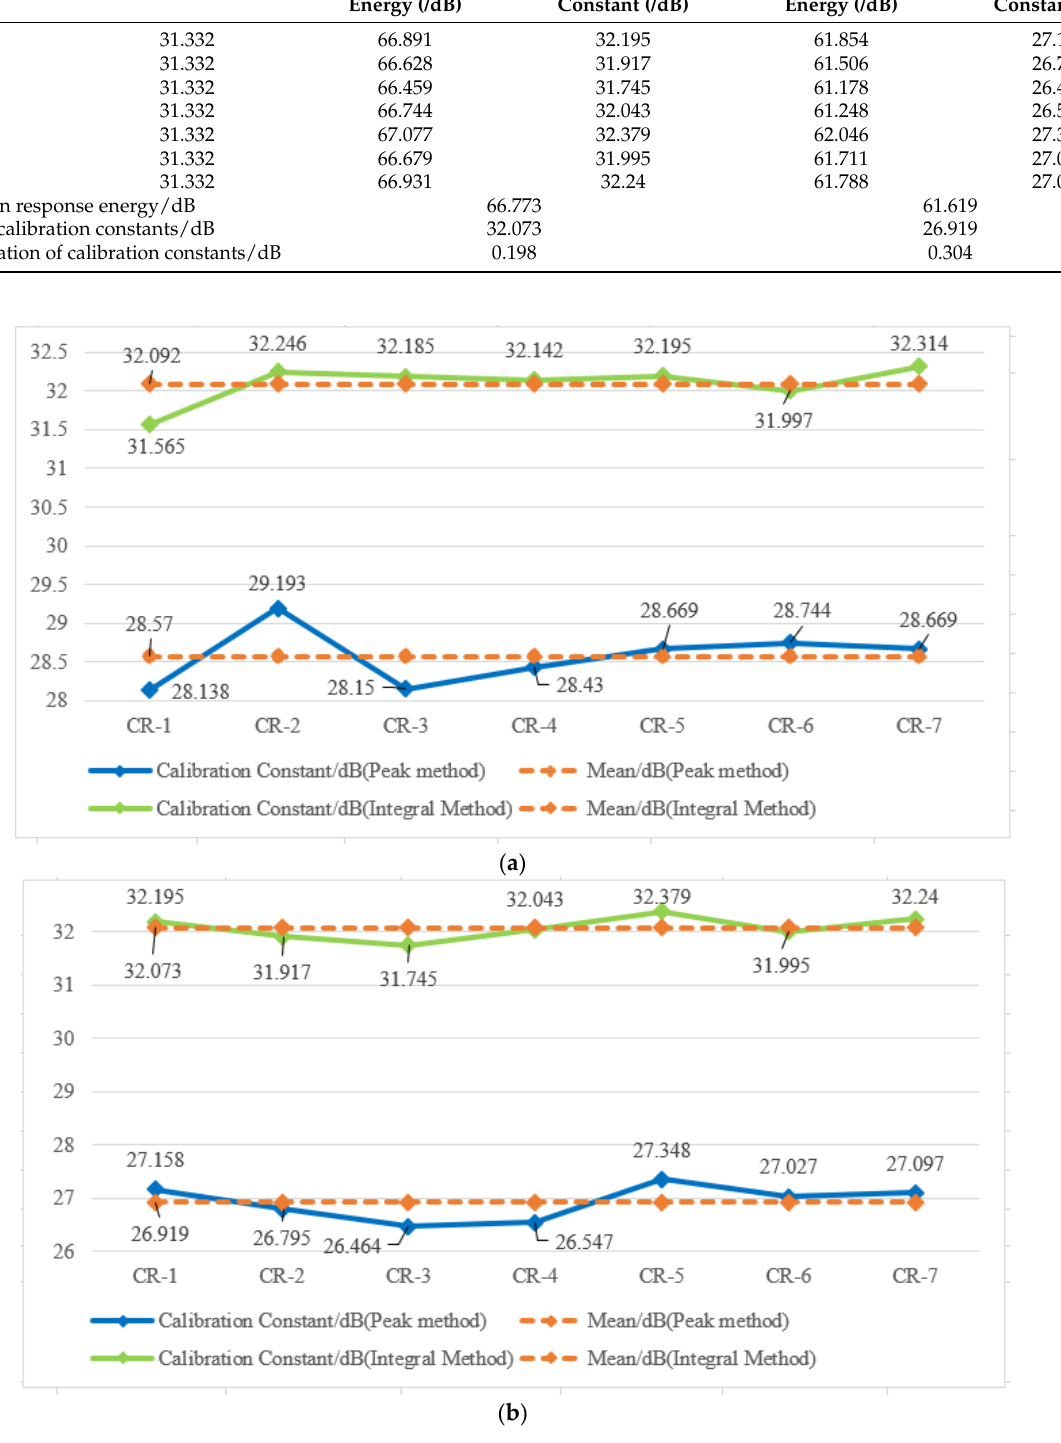
Figure 11. Results of calibration constants based on automatic angle reflectors for ( a ) UFS mode data and ( b ) FSI mode data. and ( b ) FSI mode